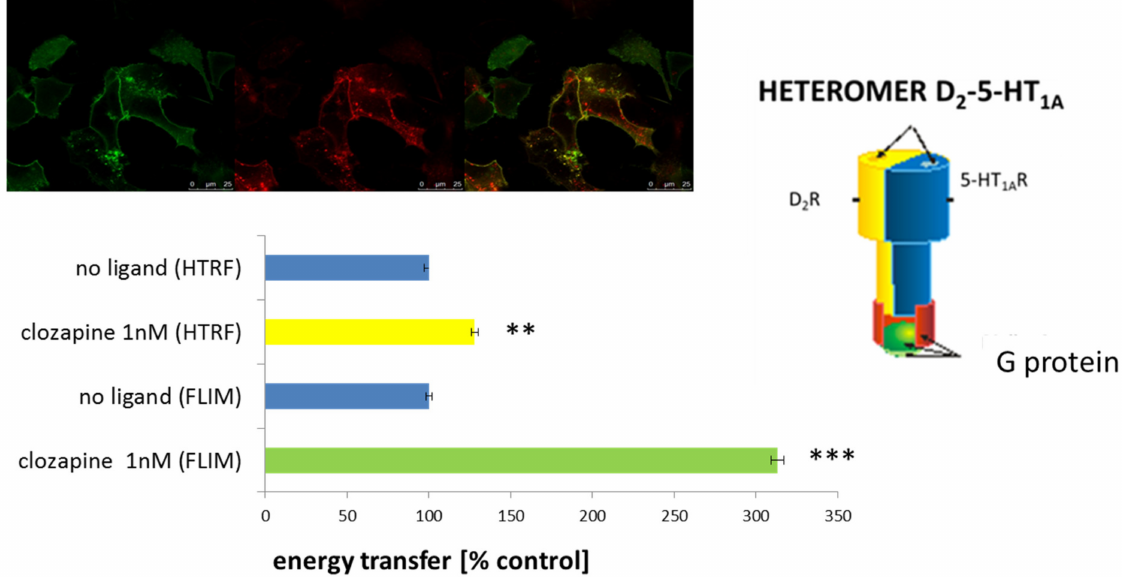
Figure 6. Constitutive dimerization of dopamine D 2 and serotonin 5-HT 1A receptors. Upper panel —HEK 293 cells expressing the dopamine D 2 (red) and serotonin 5-HT 1A (green) receptors; colocalization of both receptors (yellow). Lower panel —bar graph presenting FRET (fluorescence resonance energy transfer) measurements using HTRF (homogenous time resolved FRET) and FLIM (fluorescence life time imagine microscopy) techniques. The statistical significance was evaluated using student t-test and Mann–Whitney U-test, ** p < 0.01, *** p < 0.001. Right panel —schematic presentation of D 2 -5-HT 1A heteromer. Detailed information